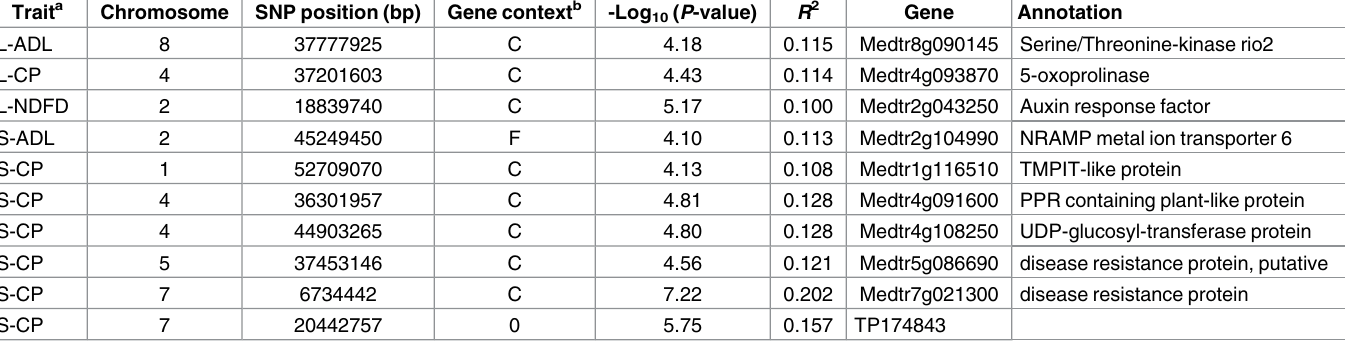
Table 3. Annotated genes or SNP markersassociated with alfalfa forage quality traits with highest association score (-Log 10 ( P -value) > 4.0) and coefficient of determination ( R 2 (cid:21) 0.10). Trait a